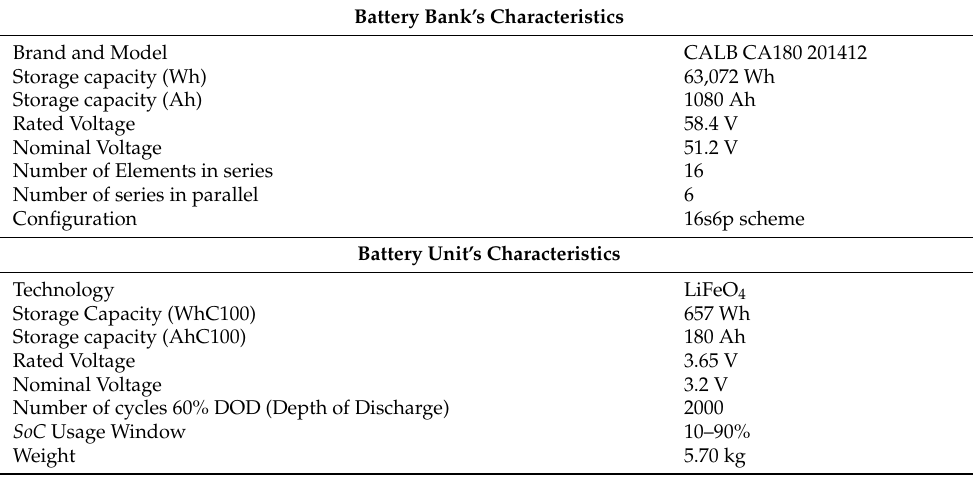
Table 3. Technical specification of the